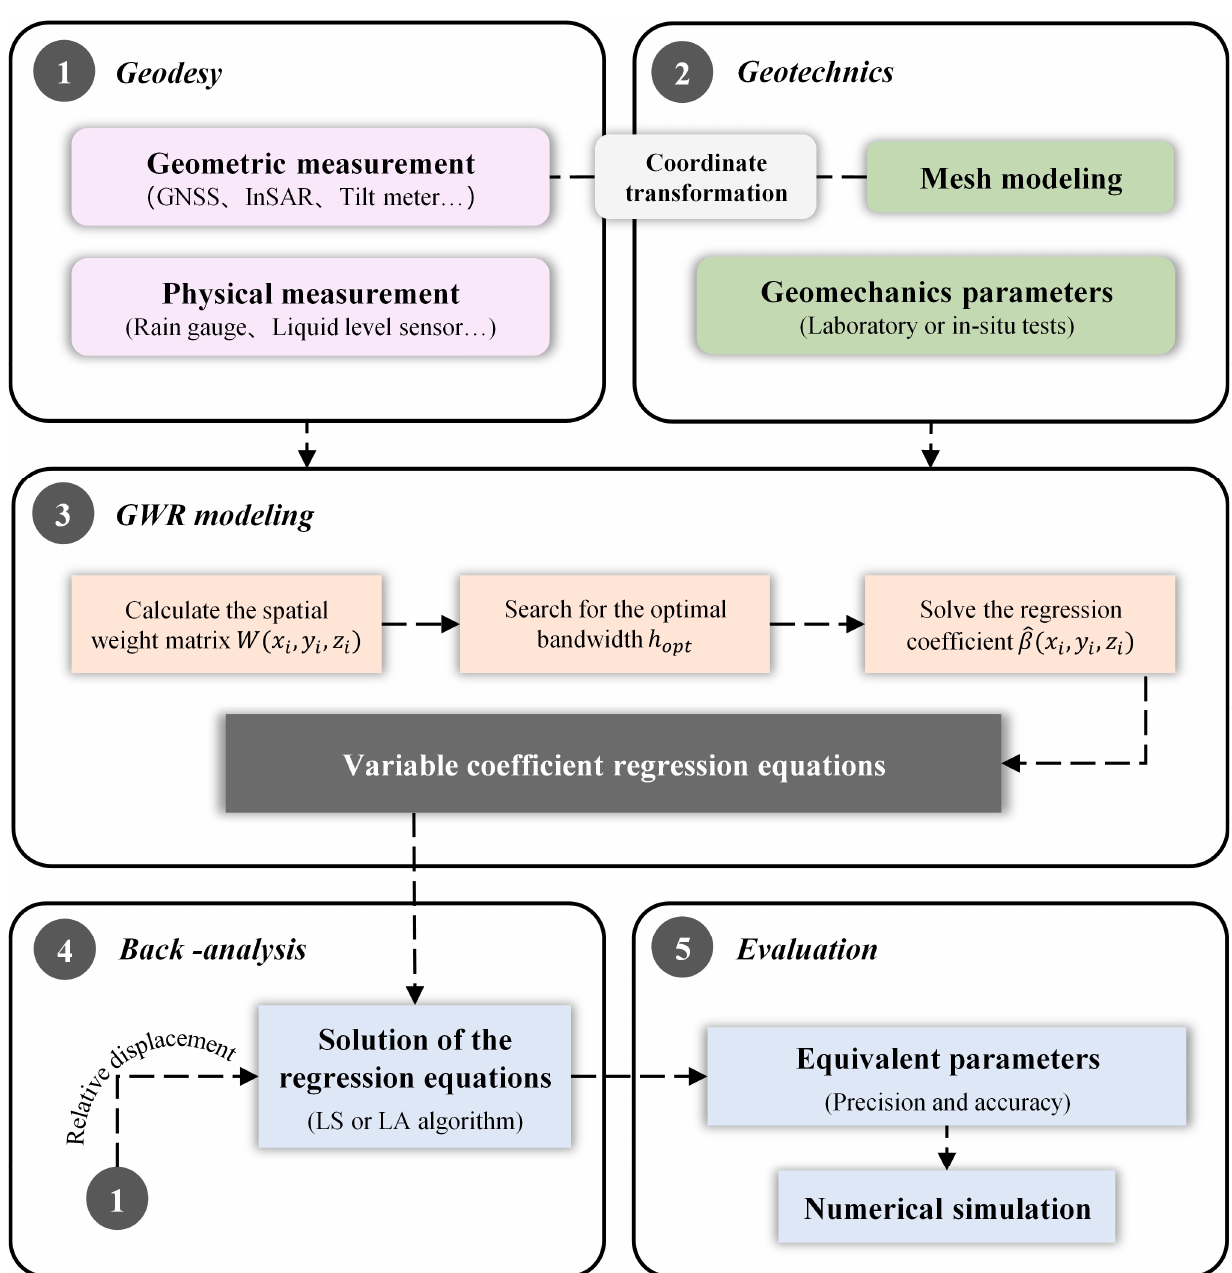
Figure 5. Flowchart for the proposed DBA-GWR method.